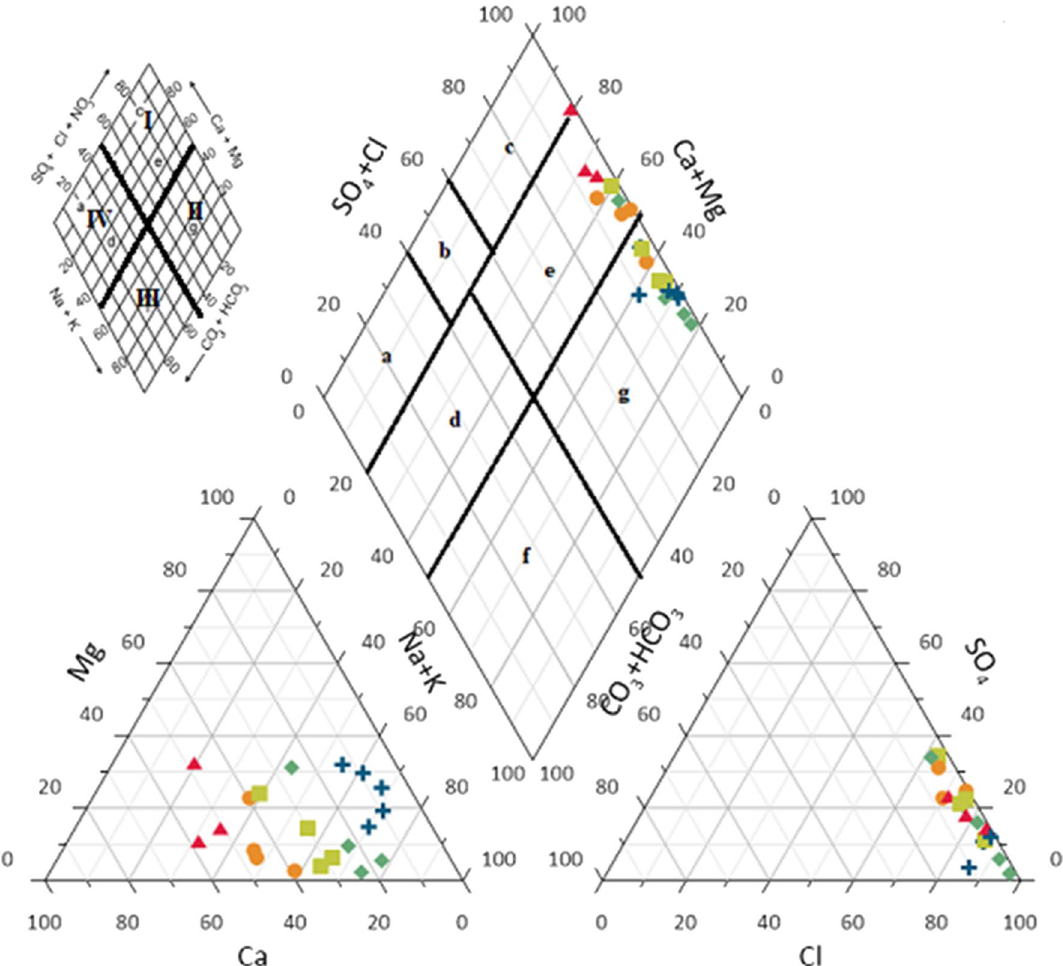
Fig. 5 Piper diagram for groundwater samples (Langguth,